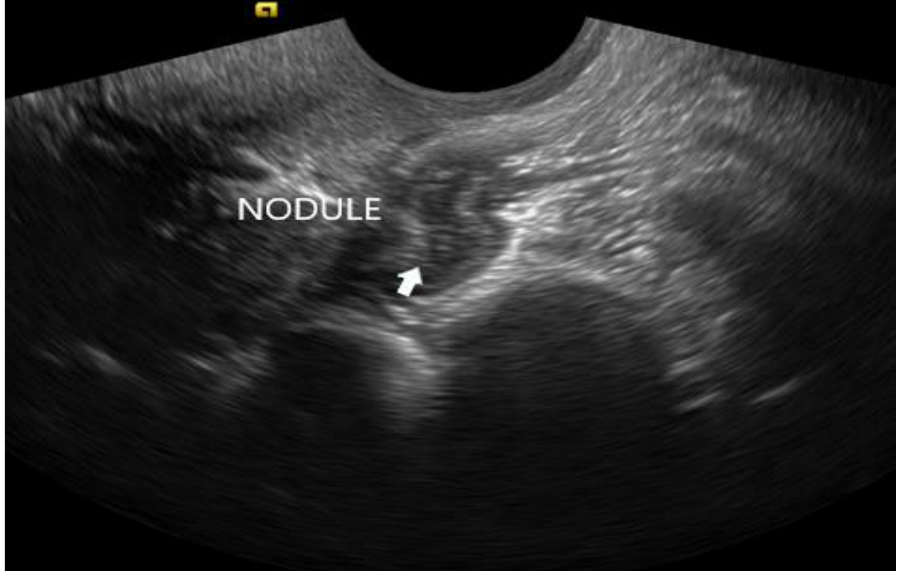
Figure 12. Deep endometriosis nodule of the anterior rectal wall, seen as an irregular hypoechoic lesion (white arrow).